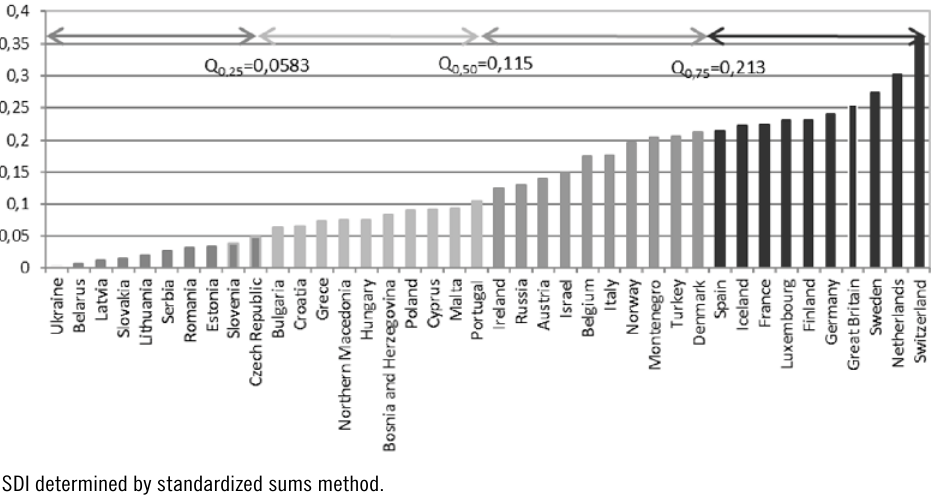
Table A3.1. Value of correlation coefficients between alternative SDI and GP _ all Pearson’s linear